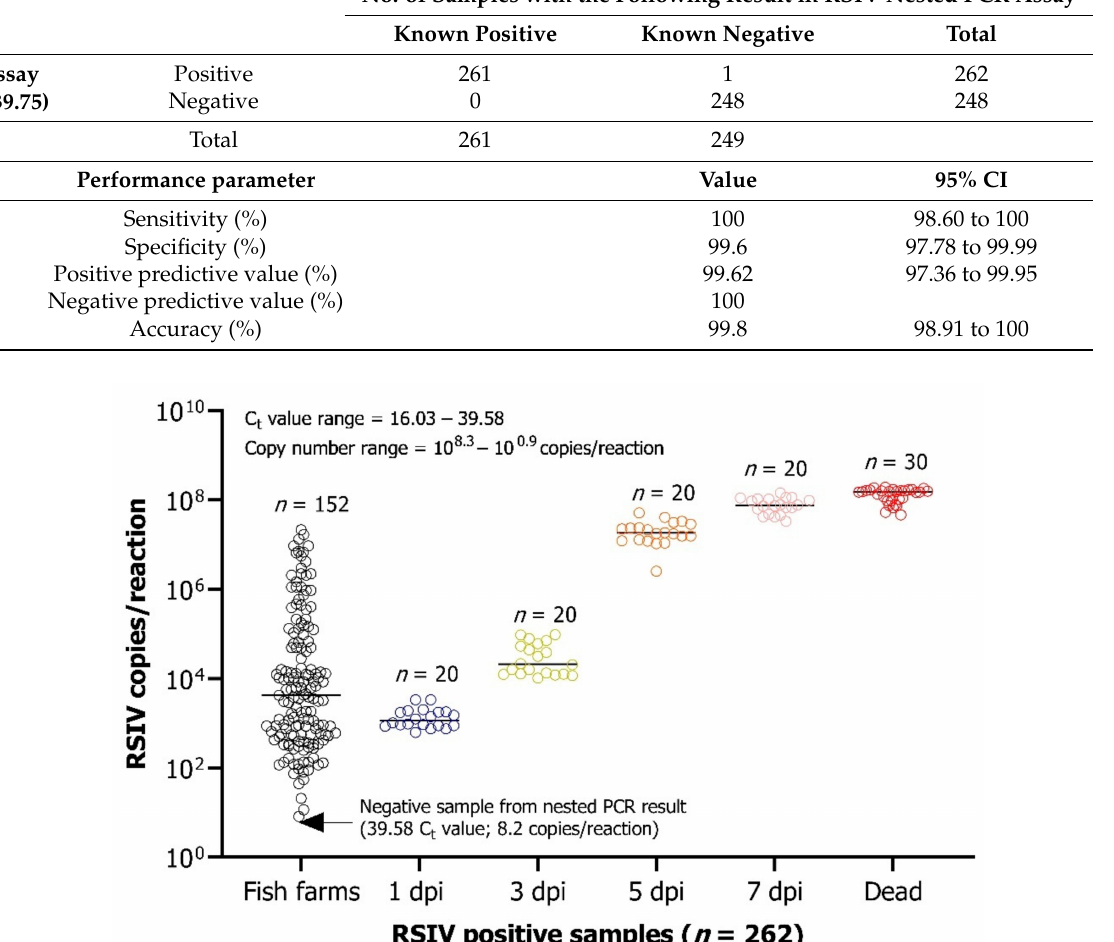
Figure 4. Quantification of the viral copy numbers of the red sea bream iridovirus (RSIV)-positive DNA samples using TaqMan-based real-time PCR analysis. The bars represent the median viral copy numbers. The black arrows indicate the sample that tested RSIV-negative in the nested PCR, and positive (8.2 copies/reaction) in the real-time